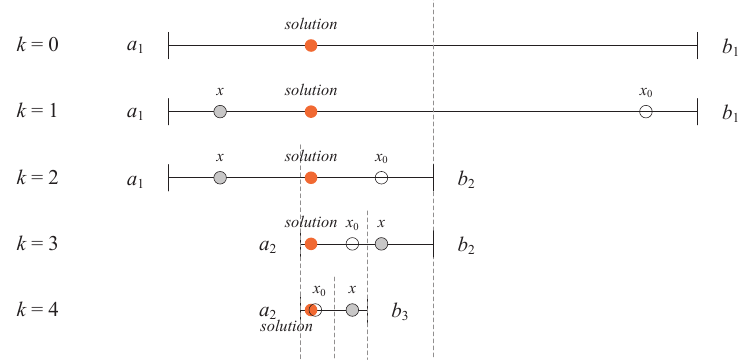
Figure 2. The process of generating the opposite